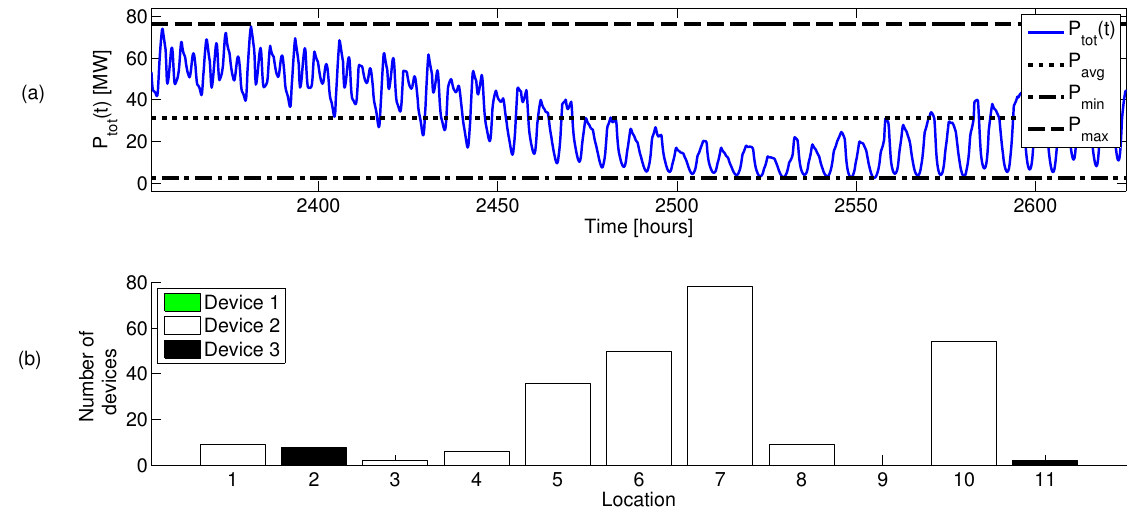
Table 4. Simulation results: values of the objective functions for Solution 1 and Solution 10.